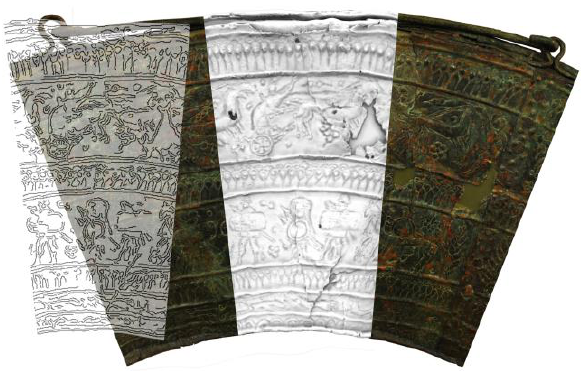
Figure 6. Graphic effects, such as the use of ambient occlusion shading and Canny algorithms, highlight surface irregularities and ease the recognition of contours of single figures.